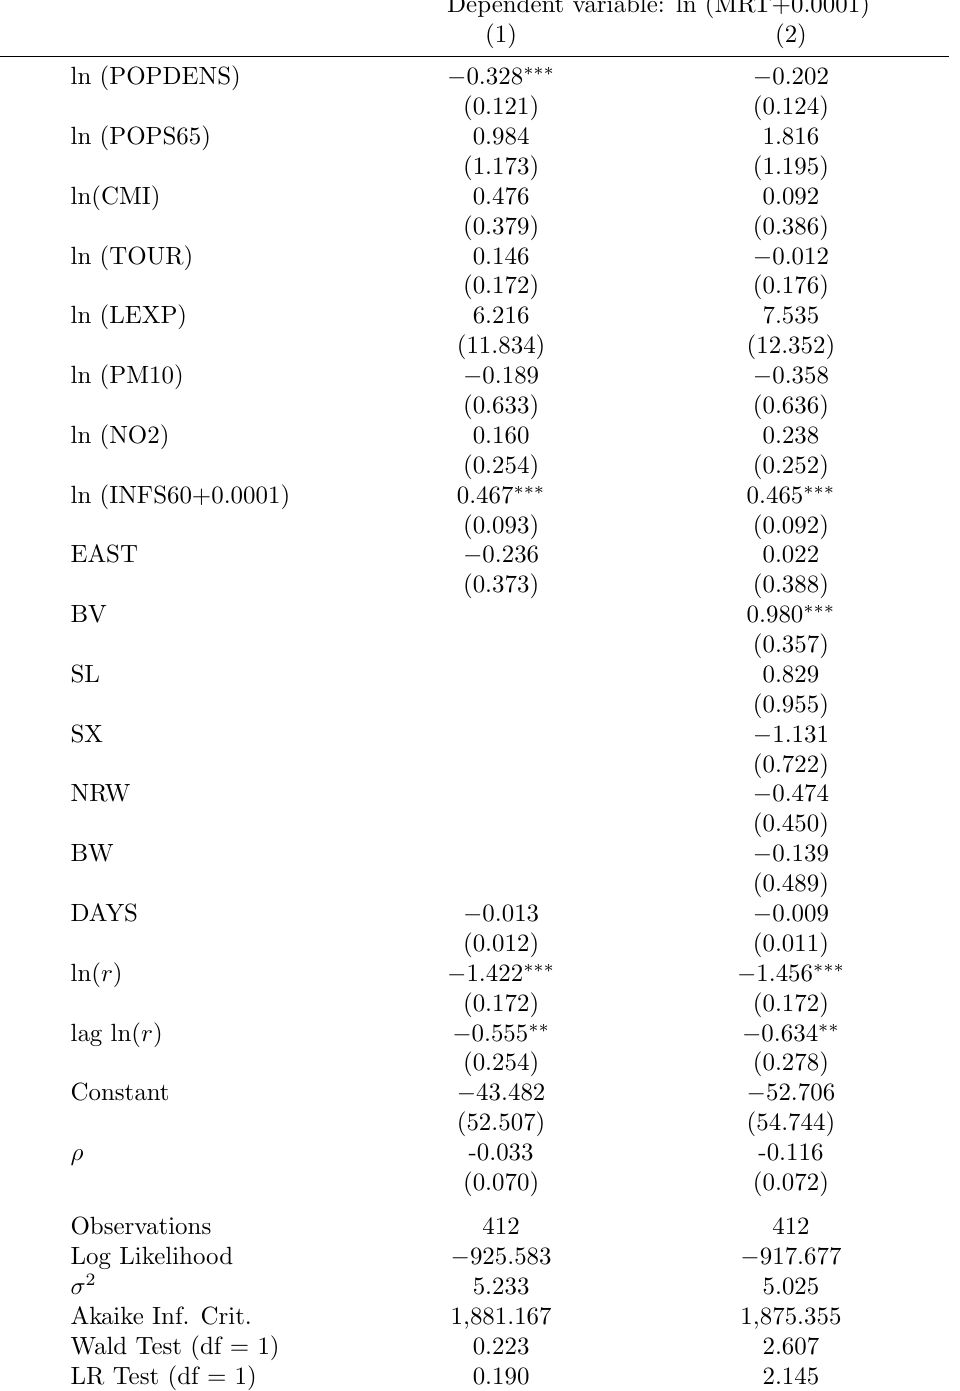
Table 12: Estimation results for the mortality model (spatial Durbin model) Dependent variable: ln